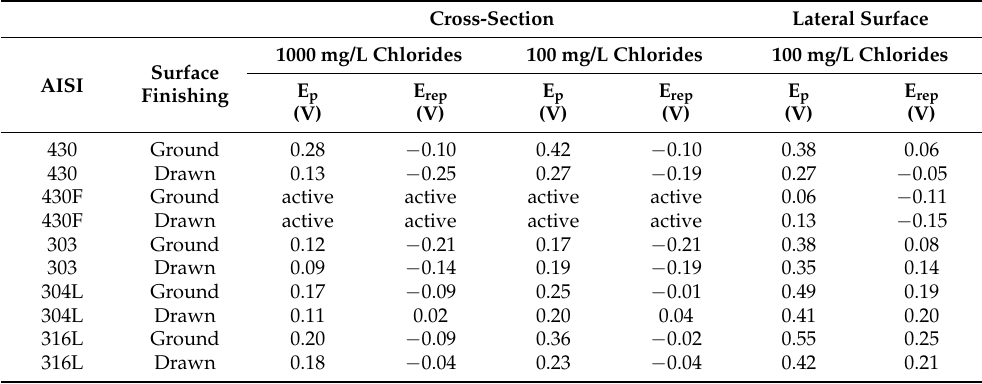
Table 4. Pitting potential (E p ) and repassivation potential (E rep ) as a function of surface finish- ing and chloride content for each steel grade tested. All the reported potential values are versus Ag/AgCl/KCl sat . Cross-Section Lateral